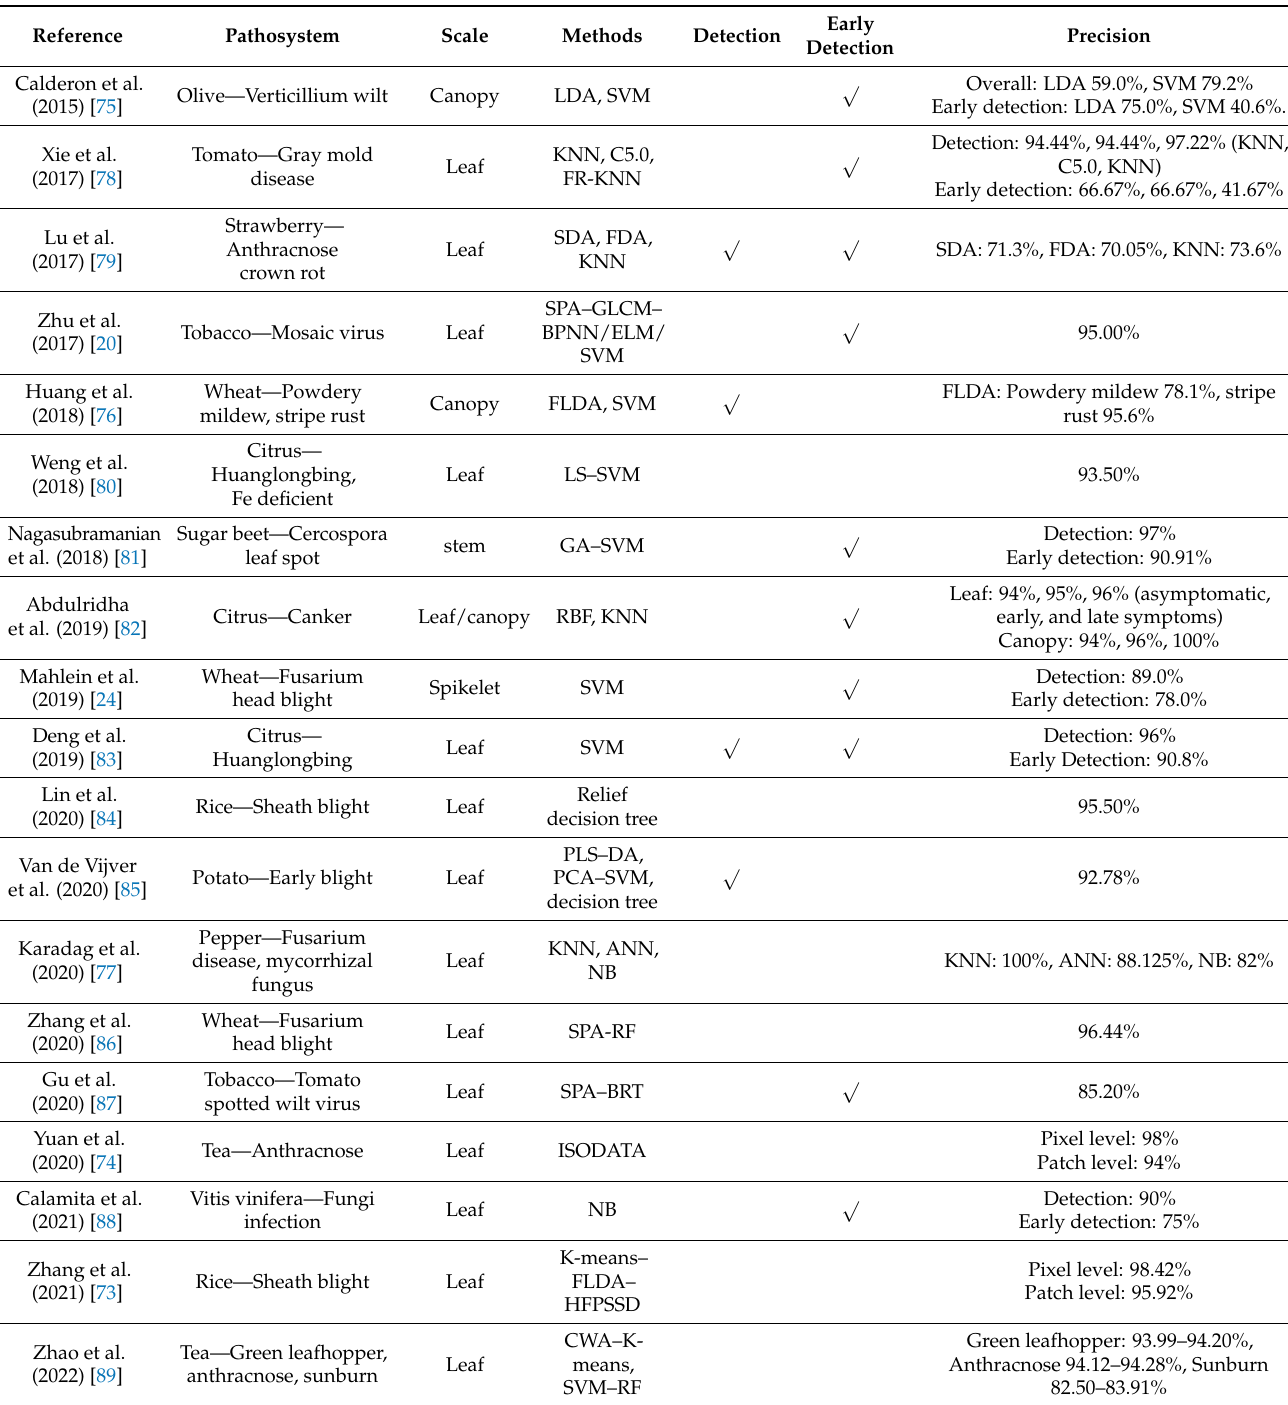
Table 3. Recent advances in plant disease detection based on machine